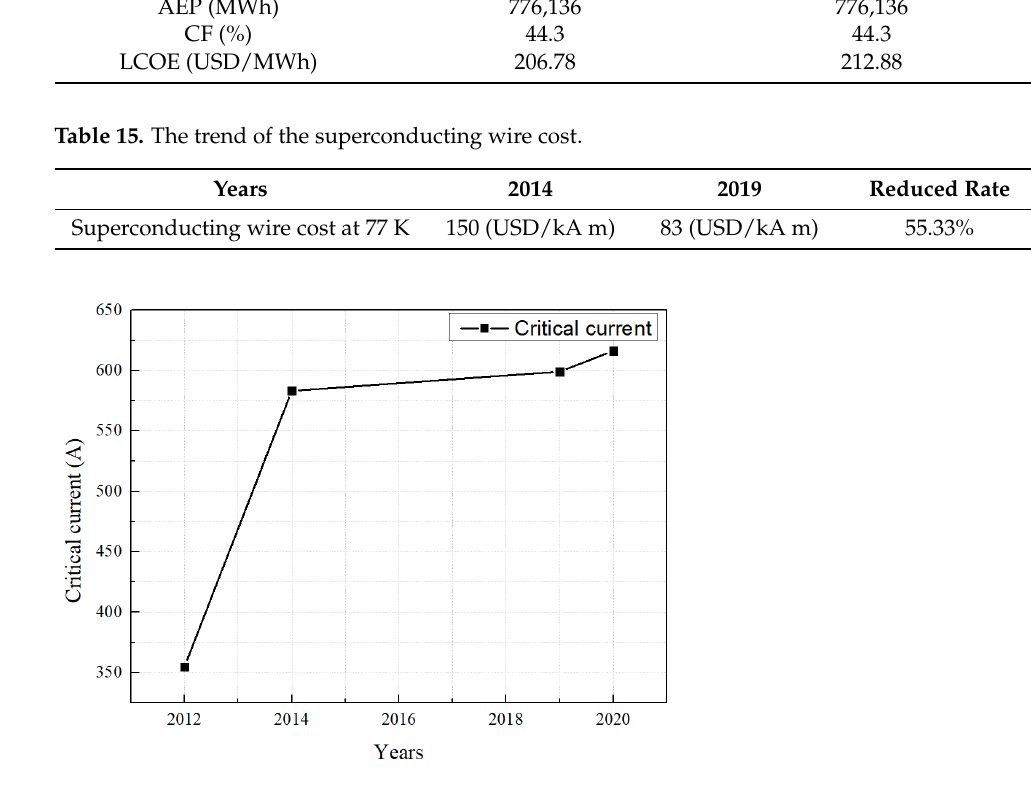
Figure 8. The critical current trend of the superconducting wire [44,45]. Table 16. The LCOE considering a 40% reduction in the superconducting wire cost of a 10 MW generator.